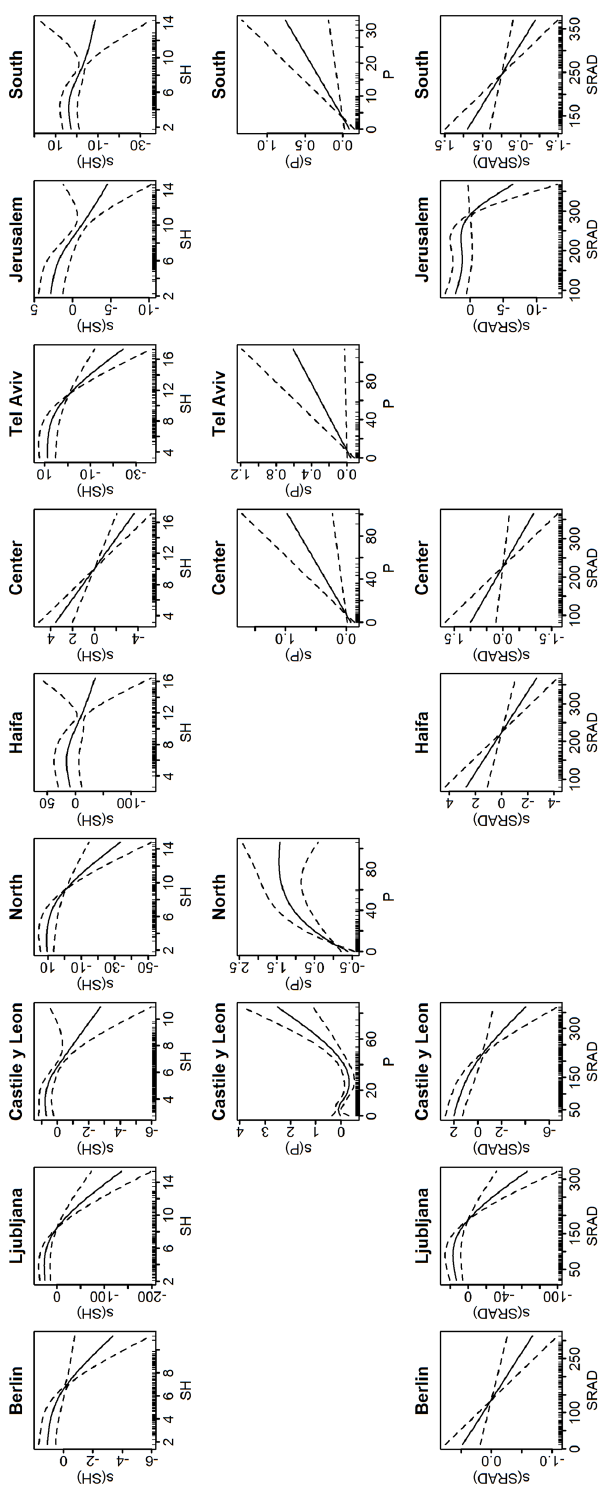
Fig 2. Plots of the meteorological smooth terms for Model 1 (with specific humidity). Only terms that are significant are plotted. The y-axis is in the predictor scale (log(y)) and normalized, while the x-axis is the value of the meteorological variable. The dashed lines are the 95% confidence interval. Downward slope indicates inverse relationship, while upward slope indicates proportional relationship.